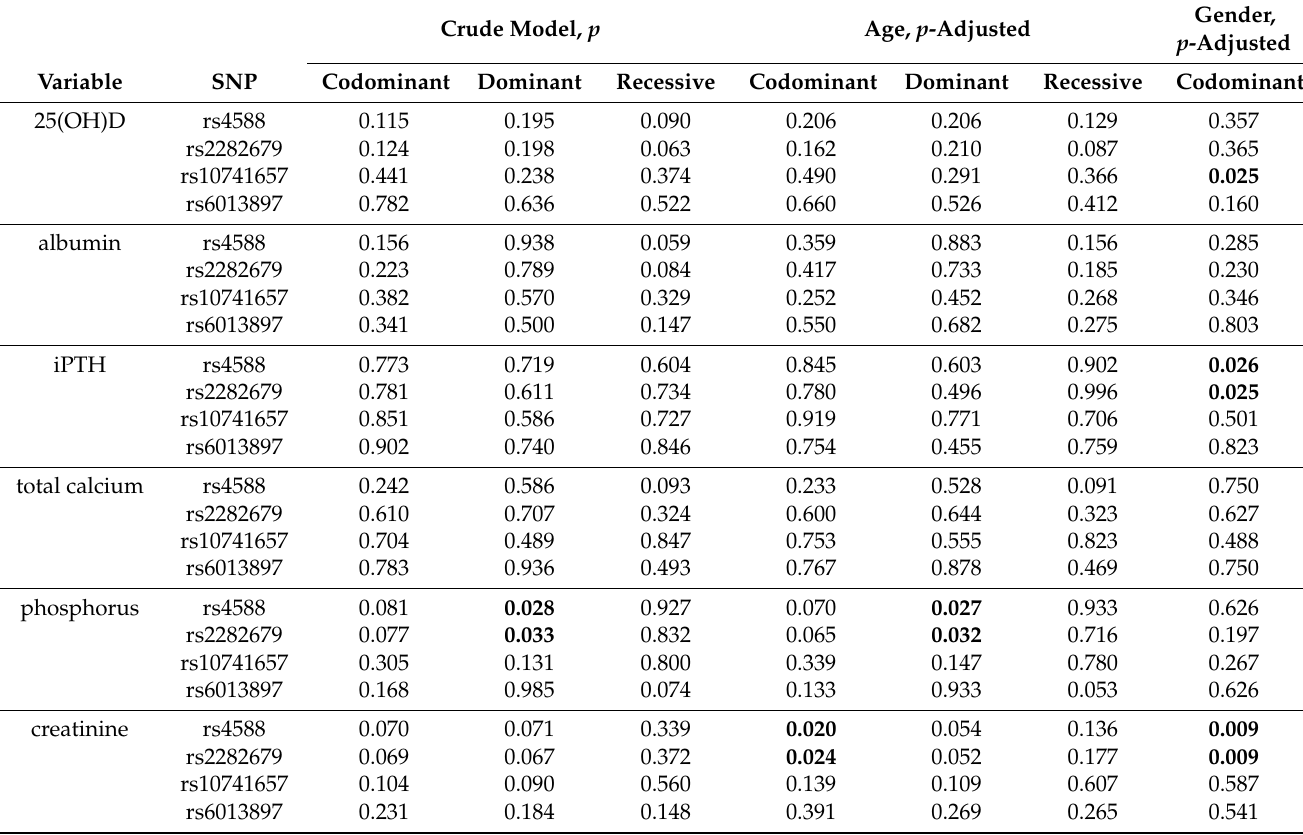
Table 4. Associations between SNPs and bone mineral metabolism